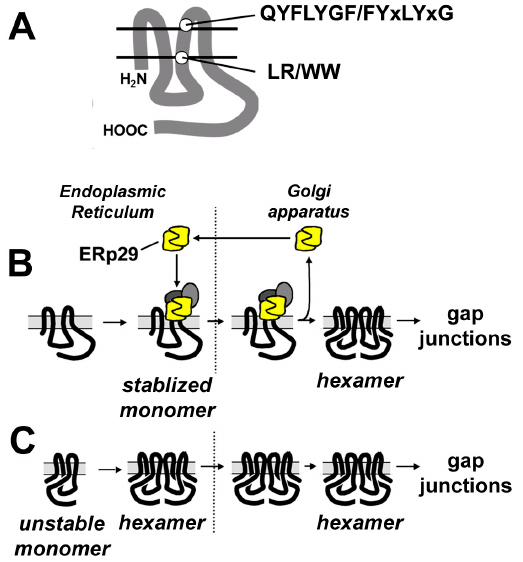
Figure 2. Differential connexin oligomerization. ( A ) Line diagram showing two key connexin motifs adjacent to the third transmembrane domain. Connexins (such as Cx43), which oligomerize in the Golgi apparatus ( B ), have a cytosolic LR and extracellular QYFLYGF motif that interacts with ERp29 (yellow) and other putative chaperones (grey ovals) that stabilize monomeric connexins until they transition from the endoplasmic reticulum (ER) to the Golgi apparatus (delineated by the dashed lines). In the Golgi apparatus, ERp29 dissociates from monomeric connexins and then recycles back to the ER, enabling connexins to oligomerize into hexameric hemichannels. By contrast, connexins (such as Cx32) that have a WW and a FYxLYxG motif cannot interact with ERp29—they are inserted into the ER membrane as unstable monomers and thus immediately oligomerize ( C